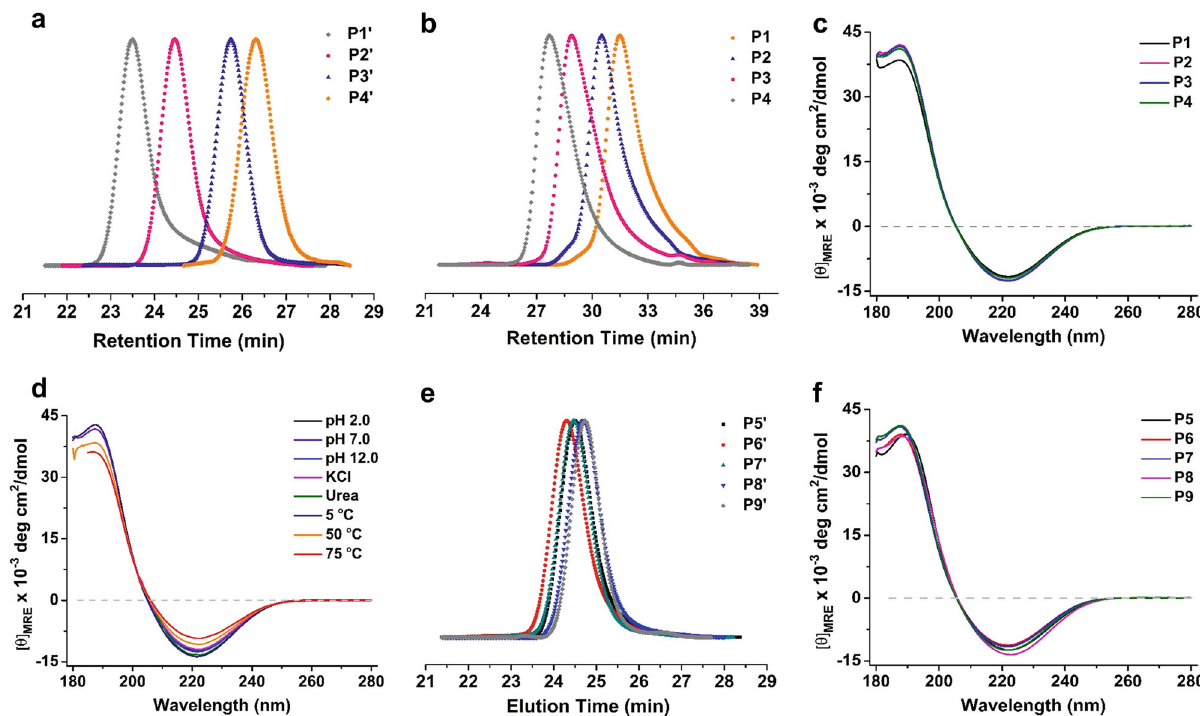
conditions; e THFGPCtracesofpolymersP5 ’ -P9 ’ ; f CDspectraofpolymersP5-P9in water at